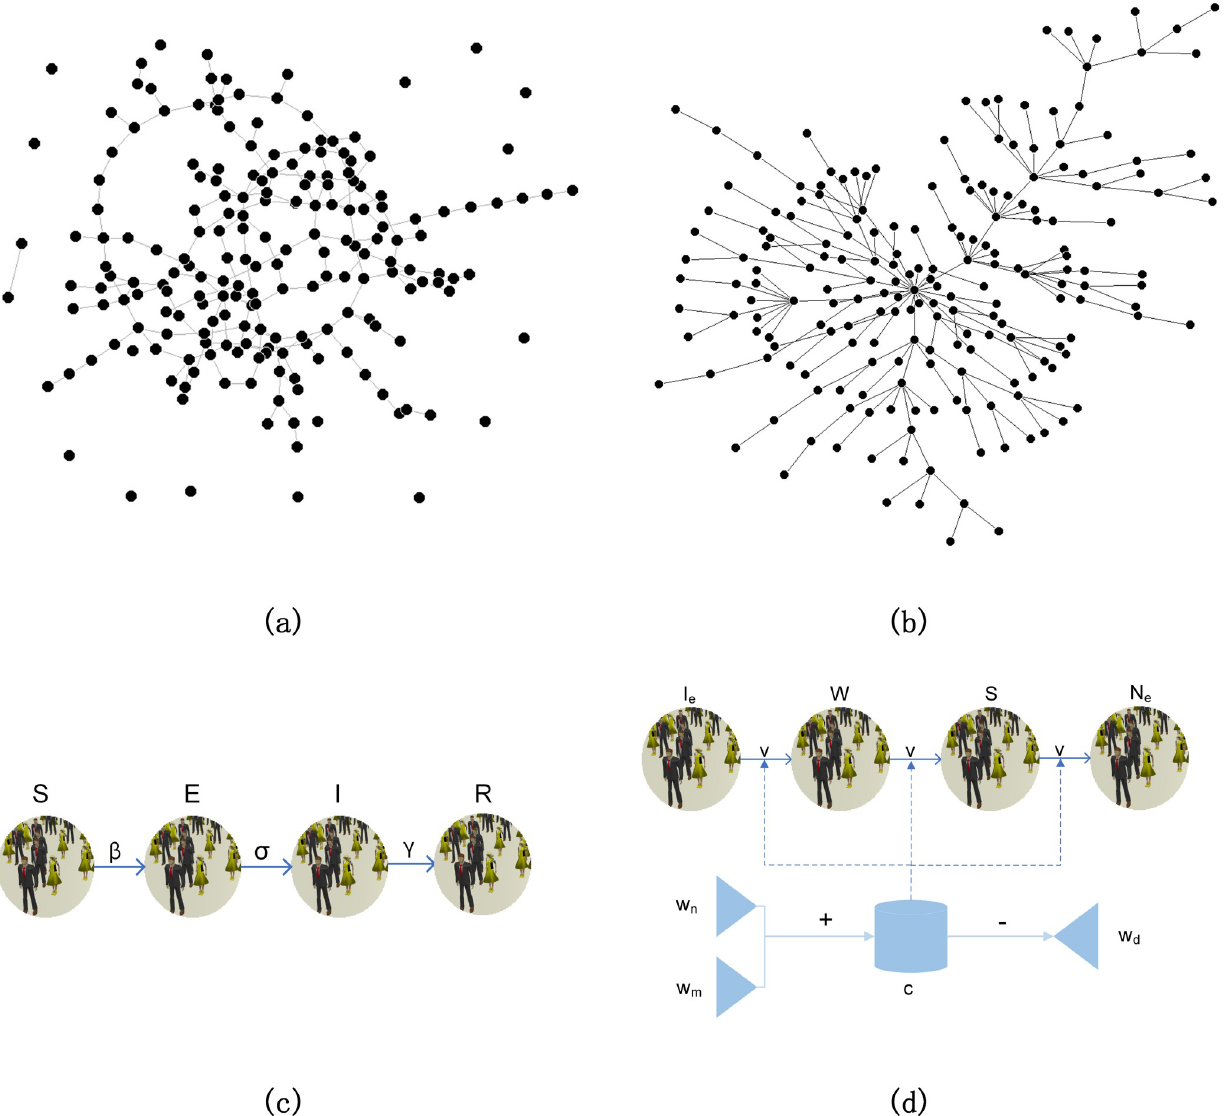
Fig 2. Illustration of the concepts and structures in our model. (a) Illustration of random network structure; (b) illustration of scale-free network structure; (c) illustration of SEIR (susceptible, exposed, infectious and recovered) model; (d) illustration of IWAN (indifferent, worried, afraid and numb) model. ‘+’ denotes increase and ‘-’ denotes decrease. Network visualization in (a) and (b) was done using the Pajek program for large network analysis [30].